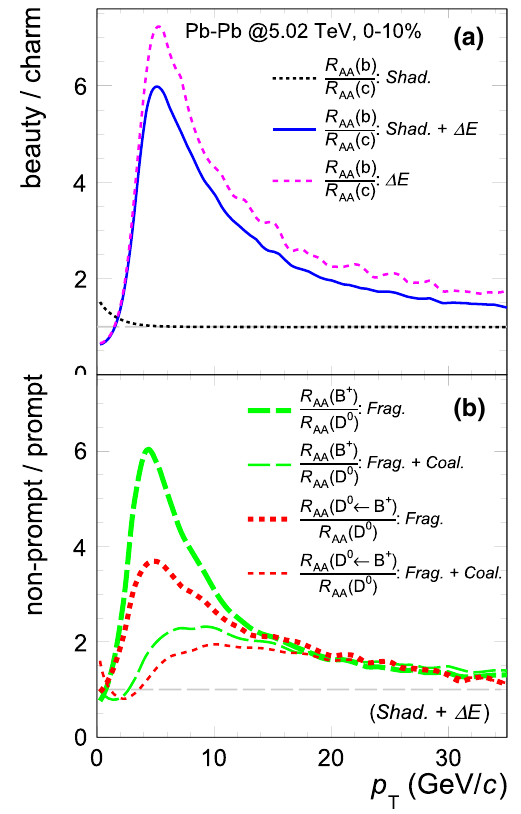
Fig. 6 Upper: the double ratio of the R AA between beauty and charm with LGR model in central (0 − 10%) Pb–Pb collisions at 5 . 02 TeV. The curves in different styles indicate the results based on different effects: nuclear shadowing (“ Shad . ”), in-medium energy loss together with collective expansion (“ Δ E ”); Bottom: same as above but for the heavy-flavor productions via fragmentation (“ Frag . ”) and heavy-light coalescence (“ Coal . ”). See legend for details